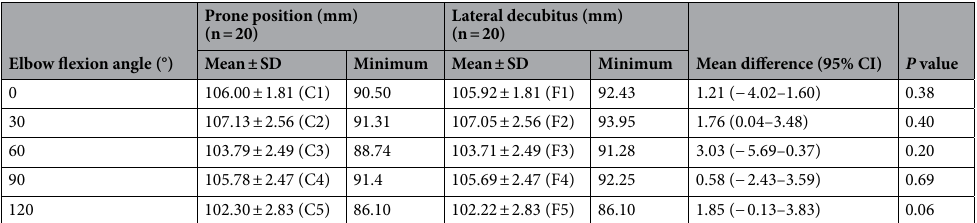
Table 2. Distances from the upper olecranon to the lateral intermuscular septum.